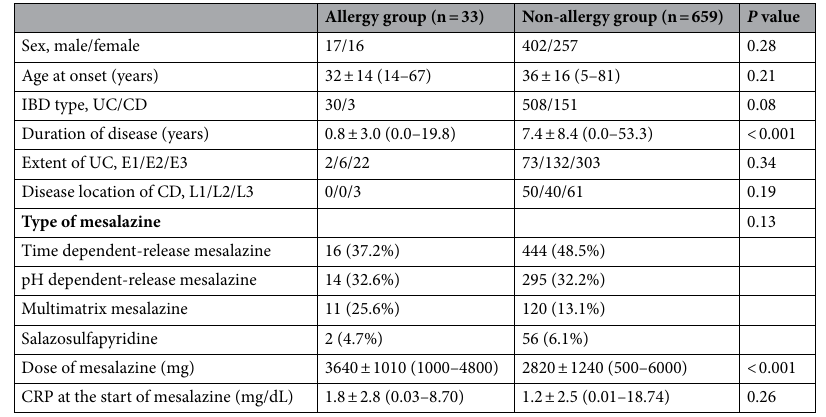
Table 2. Baseline characteristics. Disease extent in UC is classified as proctitis [E1], left-sided [E2] or extensive colitis [E3]. Disease location in CD is classified as ileum [L1], colon [L2] or ileocolon [L3]. IBD inflammatory bowel disease, UC ulcerative colitis, CD Crohn’s disease, CRP C-reactive